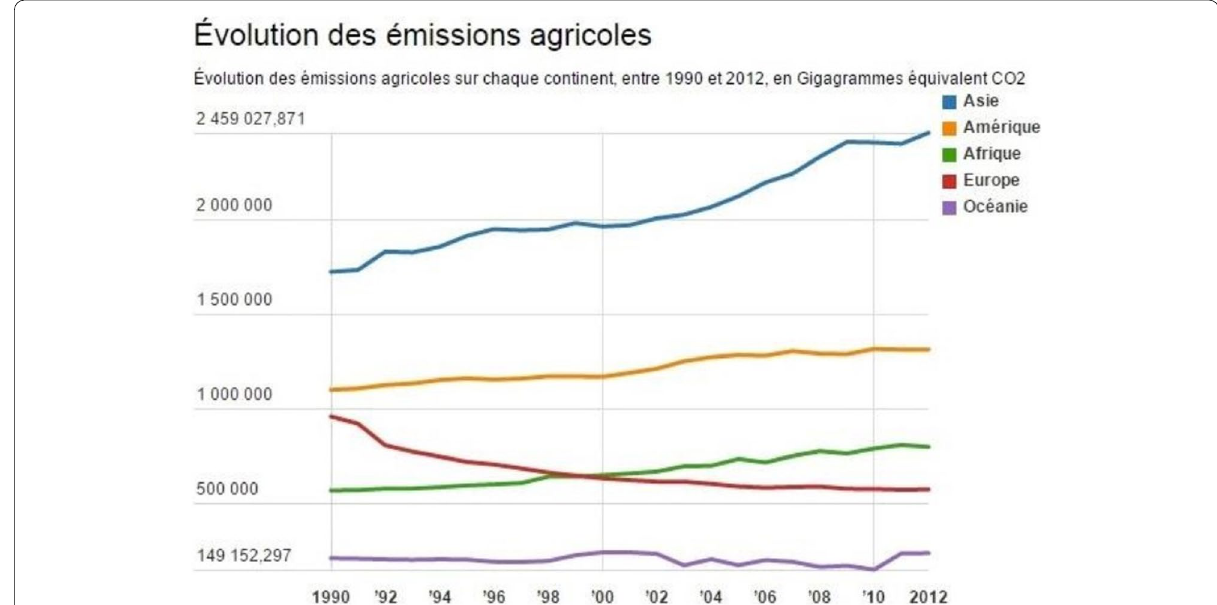
Fig. 2 Representative slide from a student presentation about Agriculture and climate change (http:// www. repor terre. net/ climat- l- agric ulture- est- la- source)